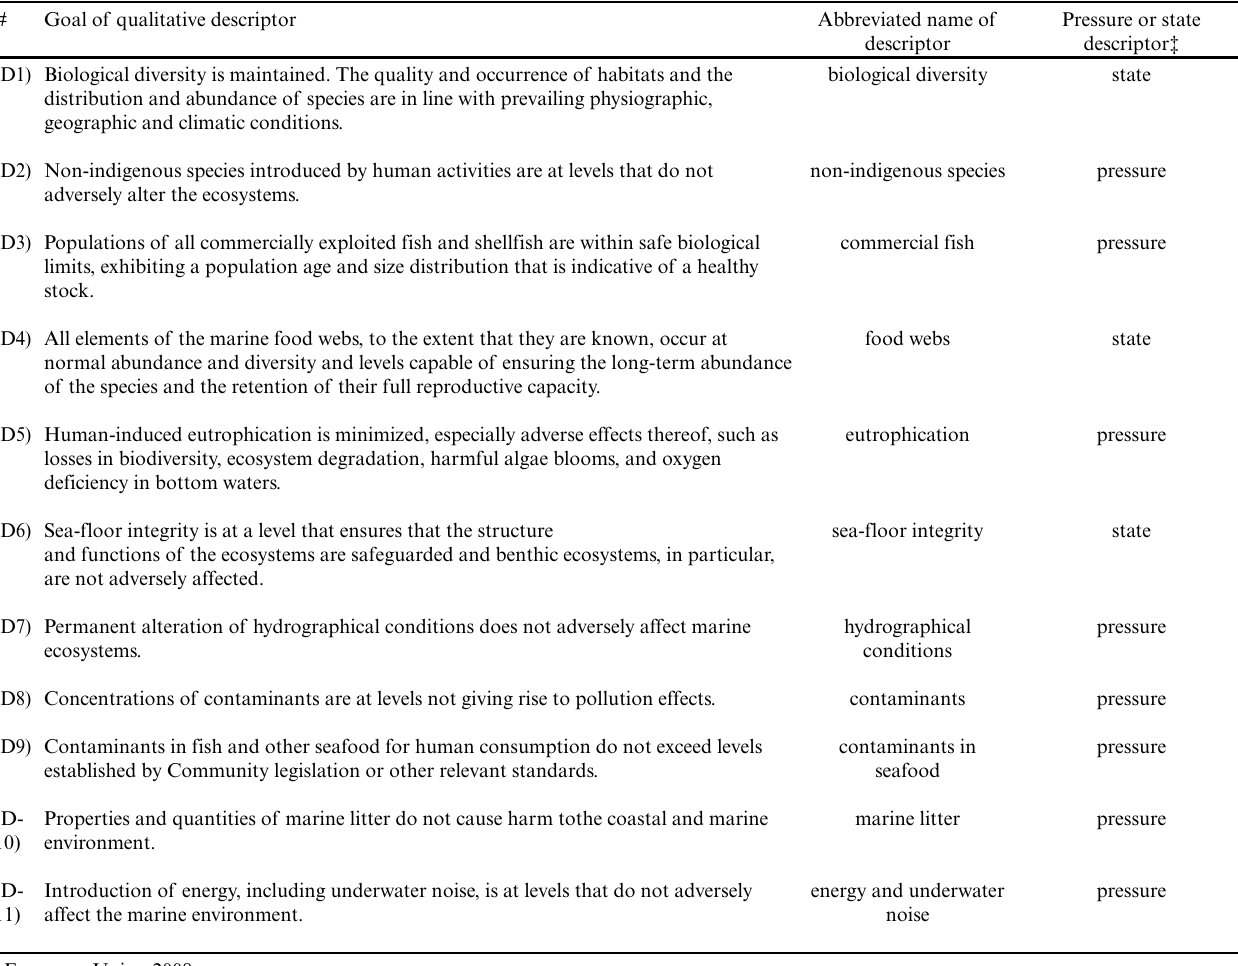
Table 1 . The qualitative descriptors for Good Environmental Status